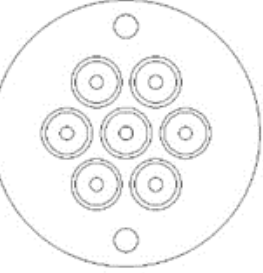
Figure 6. Computer-aided design drawing of the seven-lens sensor head, lens side, with optical axis pitch of 7.00 mm.